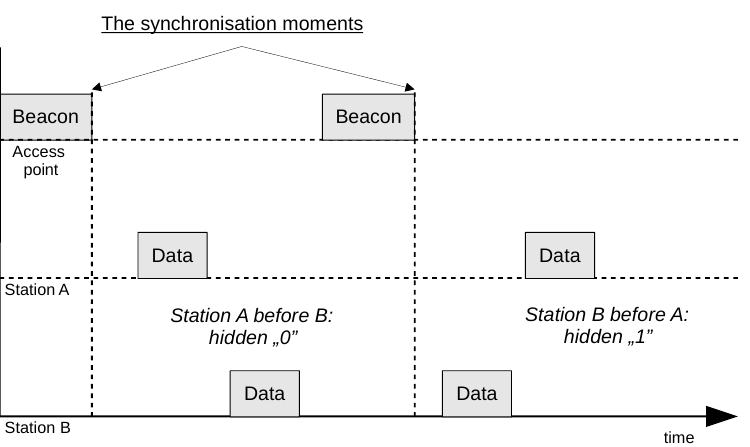
Figure 2. Example of covert bit